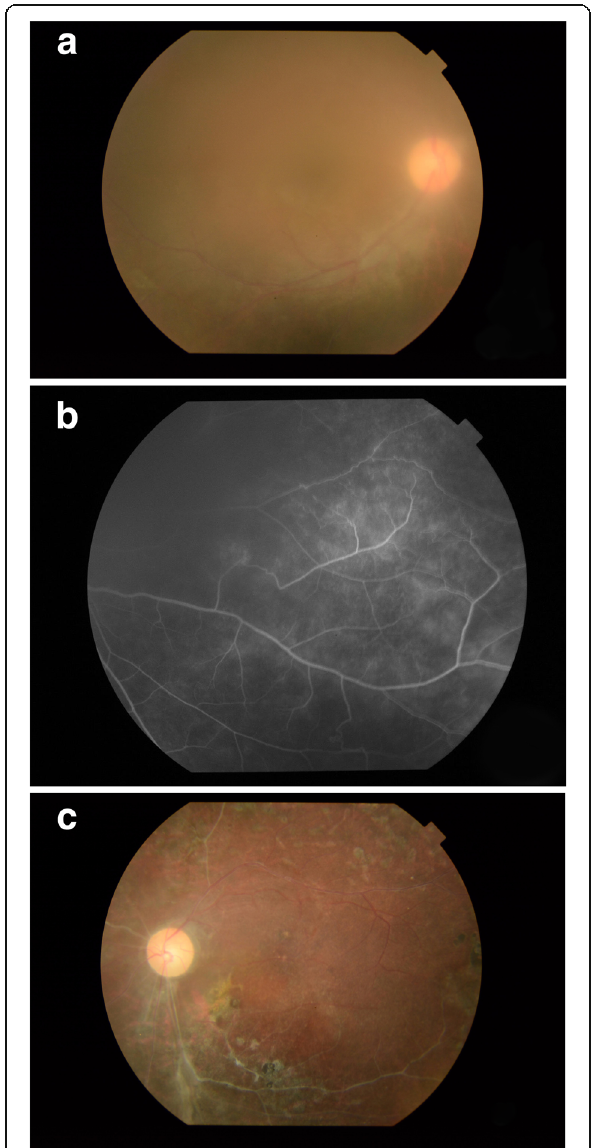
Fig. 1 a Patient 2 presented with dense vitritis during ocular relapses before adalimumab use. b Evidence of peripheral periphlebitis, with obliterative pattern affecting both the arteries and veins in peripheral retina of the same patient during relapse. c Fundus photo of the same patient showing the consequence of chronic inflammation of patient 2. It shows evidence of sclerotic and occluded retinal vessels after repeated episodes of retinal vasculitis and vascular occlusions